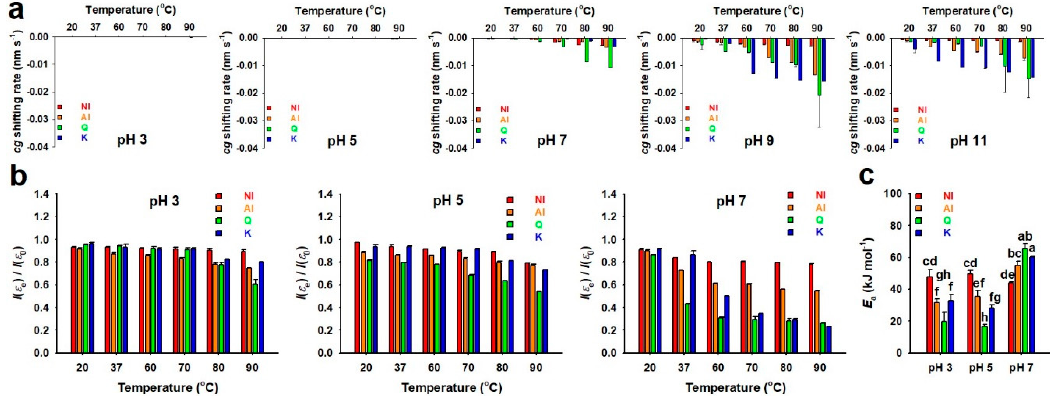
Figure 3. Stability of the non-hydrolyzed isolate (NI) and acidolyzed isolate (AI) of Ginkgo biloba leaf, quercetin (Q), and kaempferol (K) at various pH ranges (3–11) and temperatures (20–90 ◦ C) during 18-h incubation. ( a ) Shifting rates of the center of gravity ( cg = ∑𝜀 (cid:2919) 𝜆 (cid:2919) /∑𝜀 (cid:2919) ; 𝜀 (cid:2919) , absorptivity at i; 𝜆 (cid:2919) , wavelength at i; 300–400 nm) in the UV-visible spectra of NI, AI, Q, and K. The cg was determined using the two segment linear fitting curves [ cg = k 1 t + cg 1 ( 0 ≤ t < t 1 ) = k 2 t + cg 2 ( t 1 ≤ t ) ] (Figure S7). Significantly different levels of the data sets are presented in Table S3. ( b ) Non-oxidized remaining ratios of integration values for the UV-visible spectra of NI, AI, Q, and K between the initiation ( I ( ε 0 ) ) and end ( I ( ε e ) ) of the incubations; the values for I ( ε e ) were determined using the exponential decay-plateau fitting curves [ ln(𝐼(𝜀)/𝐼(𝜀 (cid:2868) )) = −𝑘𝑡 (cid:3435)0 ≤ 𝑡 < 𝑡 (cid:2926) (cid:3439) = 𝑝 (𝑡 (cid:2926) ≤ 𝑡) ] (Figure S8). Significantly di ff erent levels of the data sets are presented in Table S4. ( c ) Activation energy values ( E a ) for NI, AI, Q, and K in the aqueous solutions at pH 3–7 and 20–90 °C. Data with different letters above the bars represent significant differences according to the Tukey’s test ( n = 3; mean ± SD; P < 0.05).